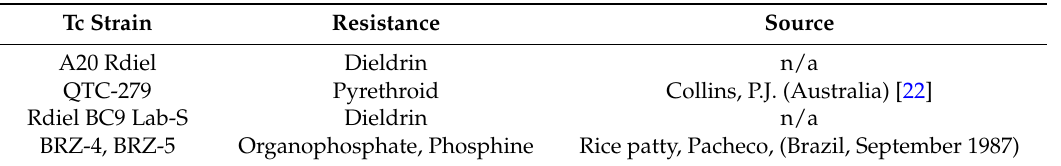
Table 1. Insecticide-resistant strains of Tribolium castaneum (Tc) maintained at the USDA ARS CGAHR (Center for Grain and Animal Health Research)